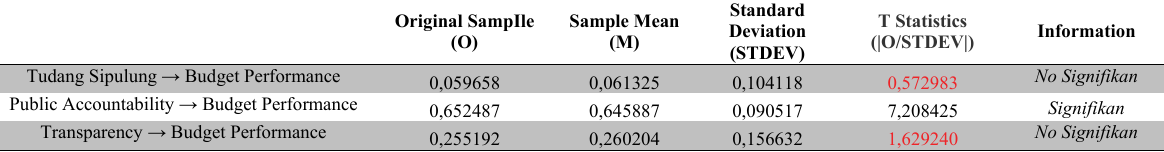
Path Coefficients (Mean, STDEV,